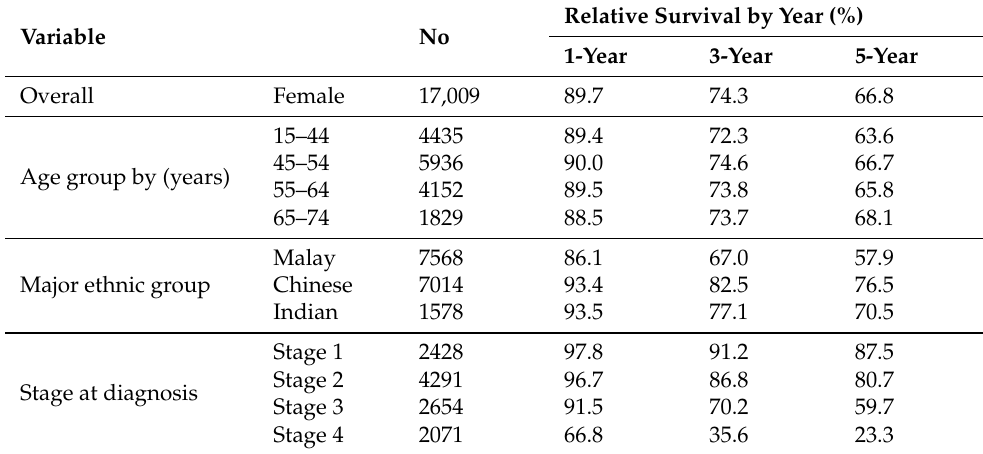
Table 2. Relative survival by stage of diagnosis and cancer types, period of diagnosis 2007–2011 and followed up to 2016, Malaysia